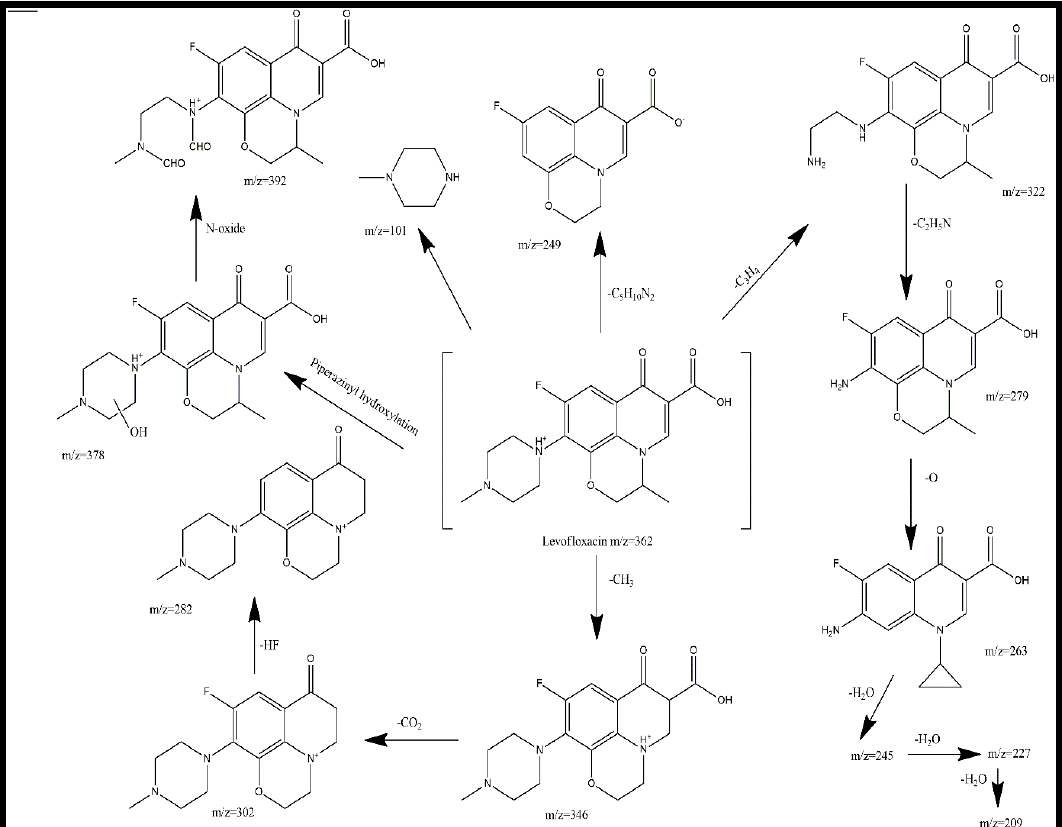
Figure 9. Identification of degradation intermediates formed during the photocatalytic reaction.